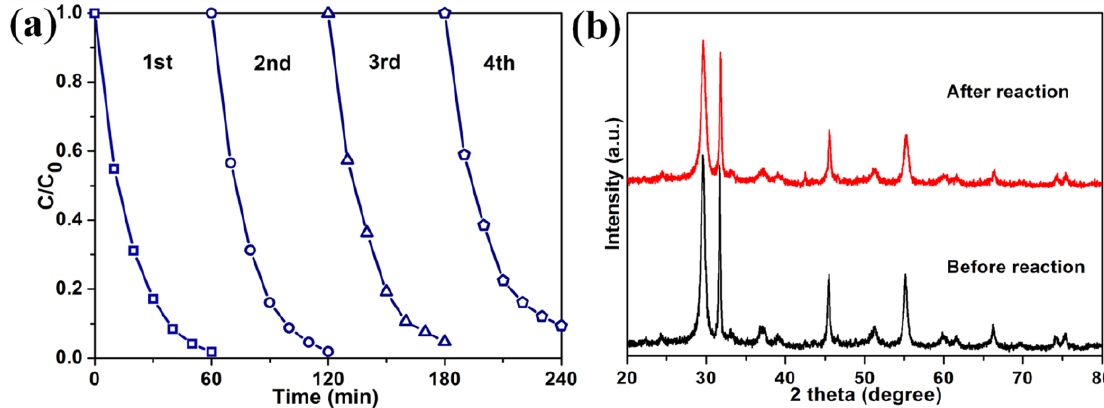
Figure 9. ( a ) Cycling runs in photocatalytic degradation of RhB (5 mg·L −1 , 50 mL) over 3%M-Bi (10 mg) under visible light (λ > 400 nm); ( b ) XRD patterns of 3%M-Bi before and after the reaction.